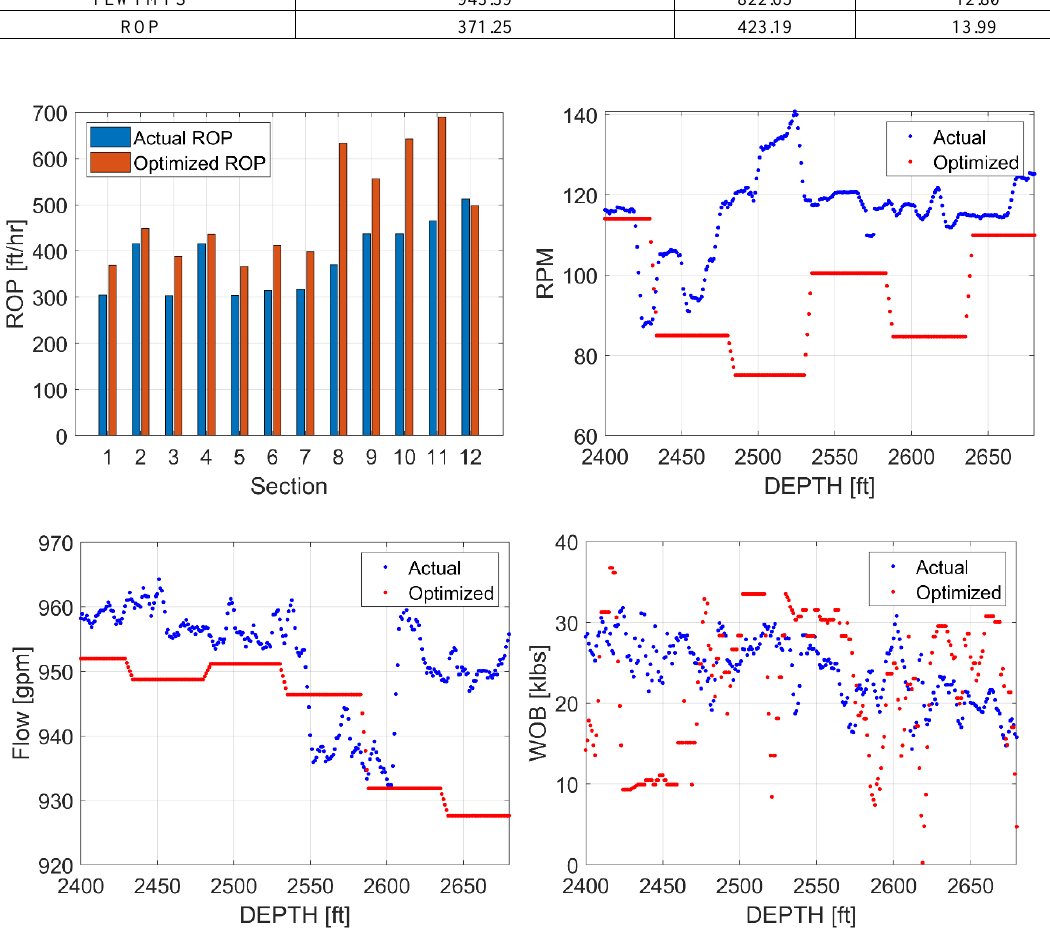
Figure 10. Actual ROP and Predicted ROP when optimizing for WOB, RPM, flow (top-left). Change in RPM (top-right), flow (bottom-left), WOB (bottom-right) for increase in